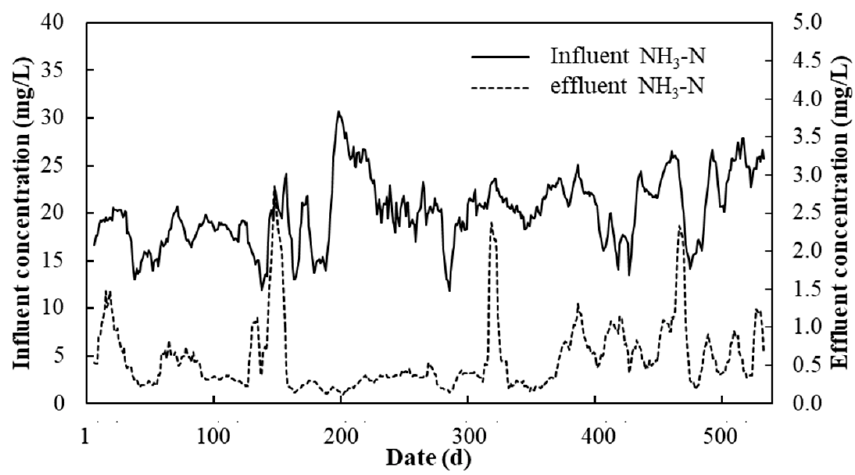
Figure 5. Influent and effluent of ammonia nitrogen in the CAST process (discharge standard: 5.0 mg/L).